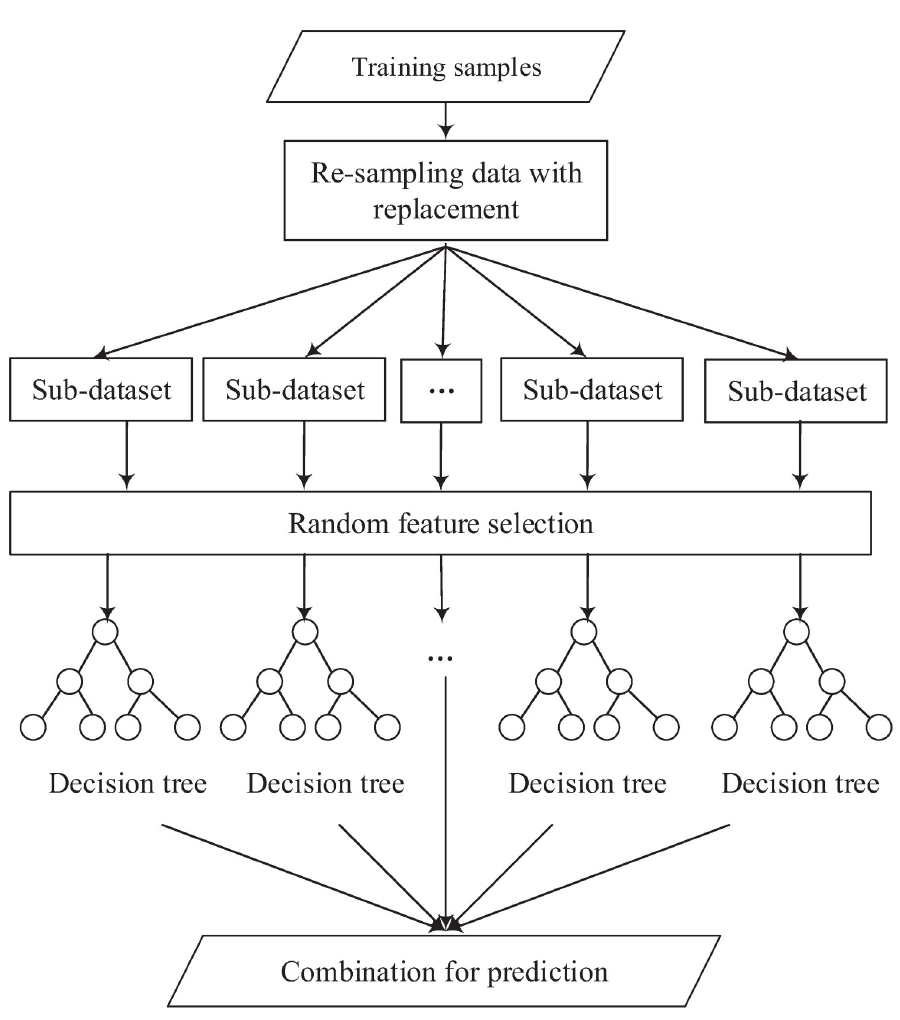
Fig 6. An example of the RF